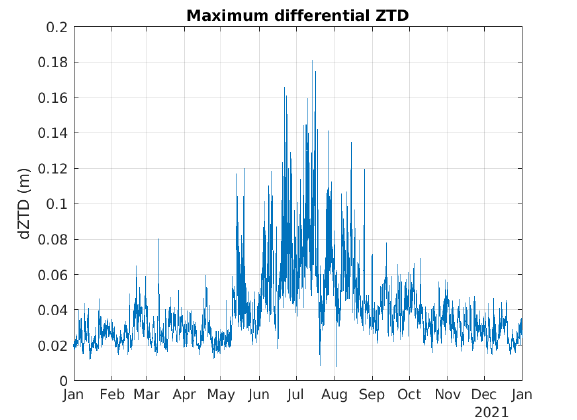
Figure 4. Maximum dZTD values as a function of time.